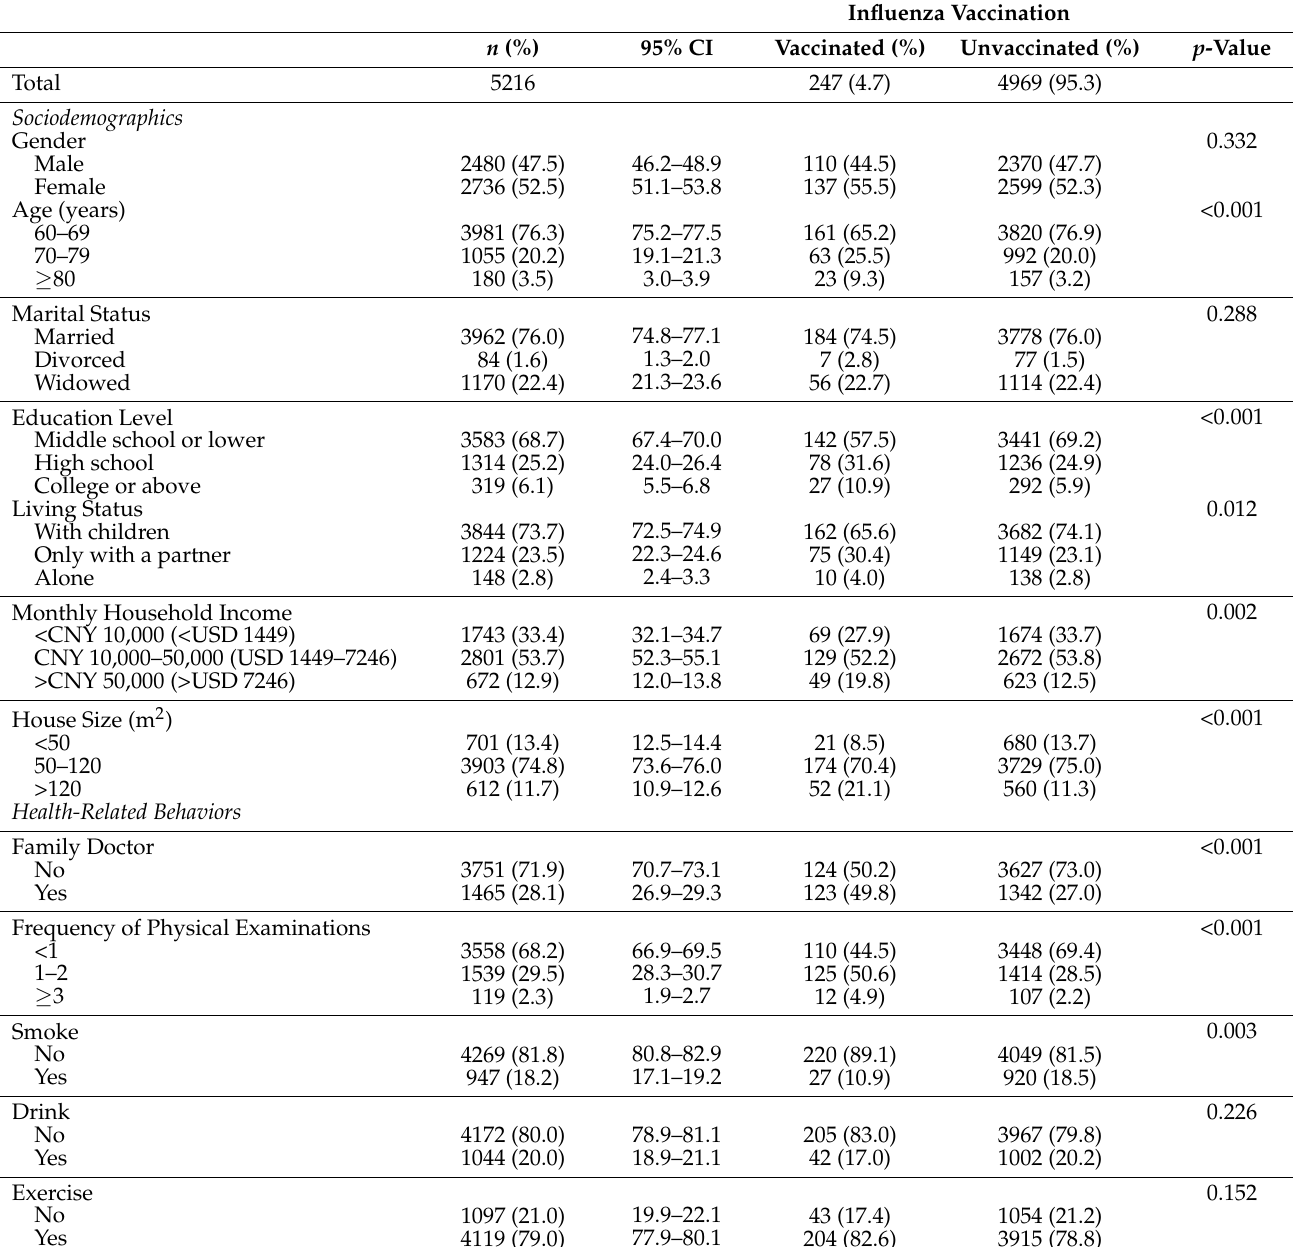
Table 1. Characteristics of the study